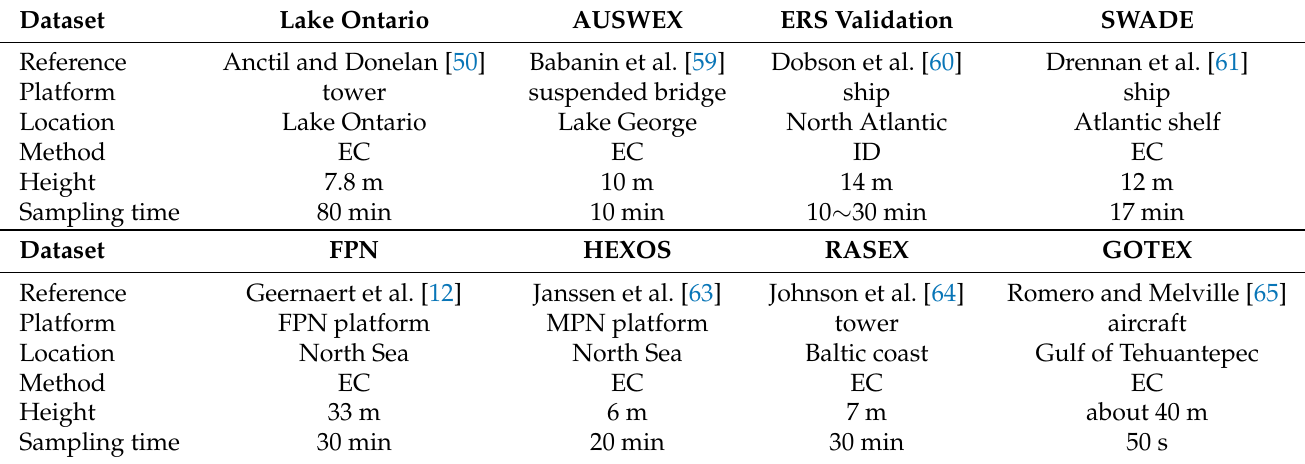
Table 2. Summary of eight datasets. The method EC denotes the wind stress was measured using direct eddy-correlation method, ID denotes the inertial dissipation